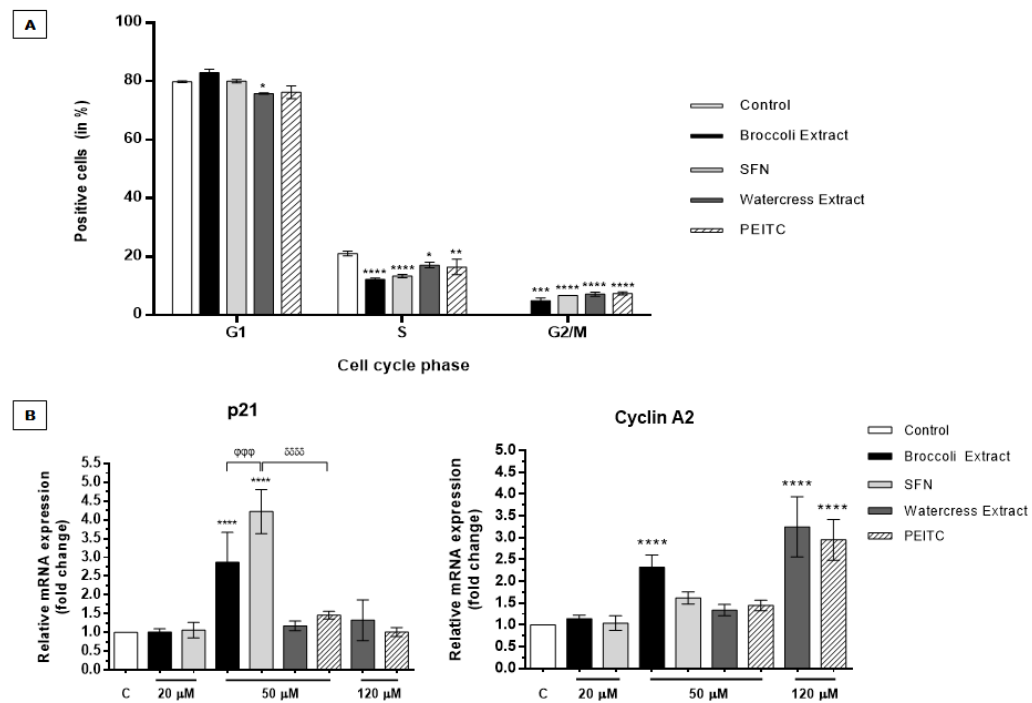
Figure 4. Brassicaceae extracts and ITCs impair cell proliferation in HT29 CRC spheroids by arresting cell cycle at G 2 /M phase and deregulating CDKN1A and CCNA2 (coding for p21 and Cyclin A2 markers) levels after exposition for 24 h. ( A ) Cell cycle distribution in HT29 spheroids analyzed by